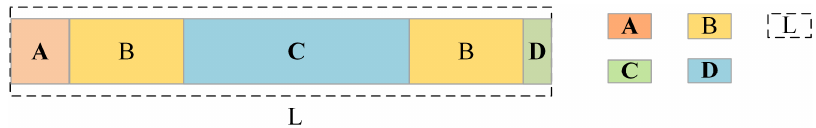
Figure 6. An example of padding from fine-grained to coarse-grained.